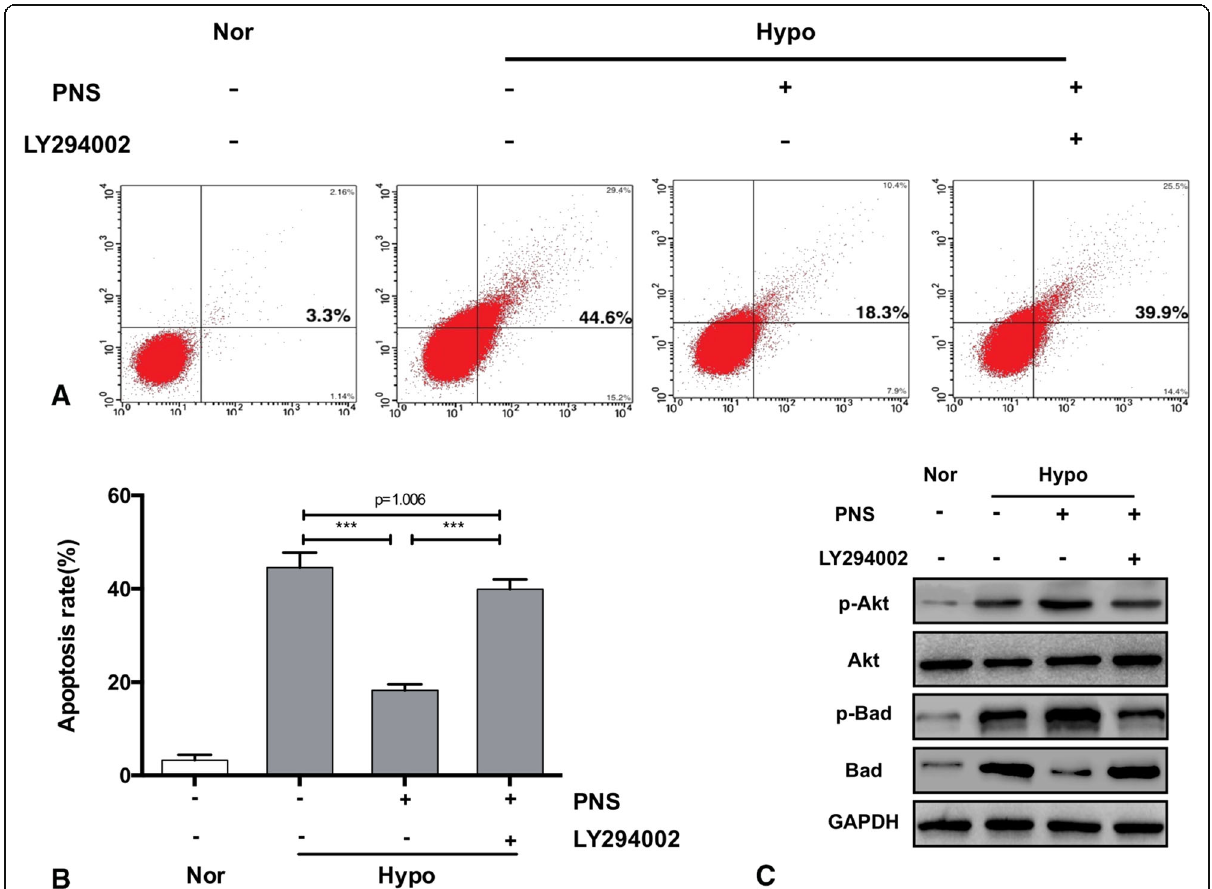
Fig. 4 PNS inhibited hypoxia-induced cellular apoptosis via the AKT/Bad pathway in vitro. Primary mouse hepatocytes were preincubated with or without 10 μ M LY294002 for 1 h and were then treated with 0.12 mg/ml PNS for 6 h before being subjected to hypoxia for 24 h. ( a ) The effect of a PI3K inhibitor on the protective activity of PNS against hypoxia-induced apoptosis in primary mouse hepatocytes was determined using Annexin V/PI staining by flow cytometry. ( b ) Quantification of ( a ). ( c ) Total and phosphorylated protein levels of AKT and Bad in primary mouse hepatocytes. Values represent the mean ± SD of at least three independent experiments; *** P<